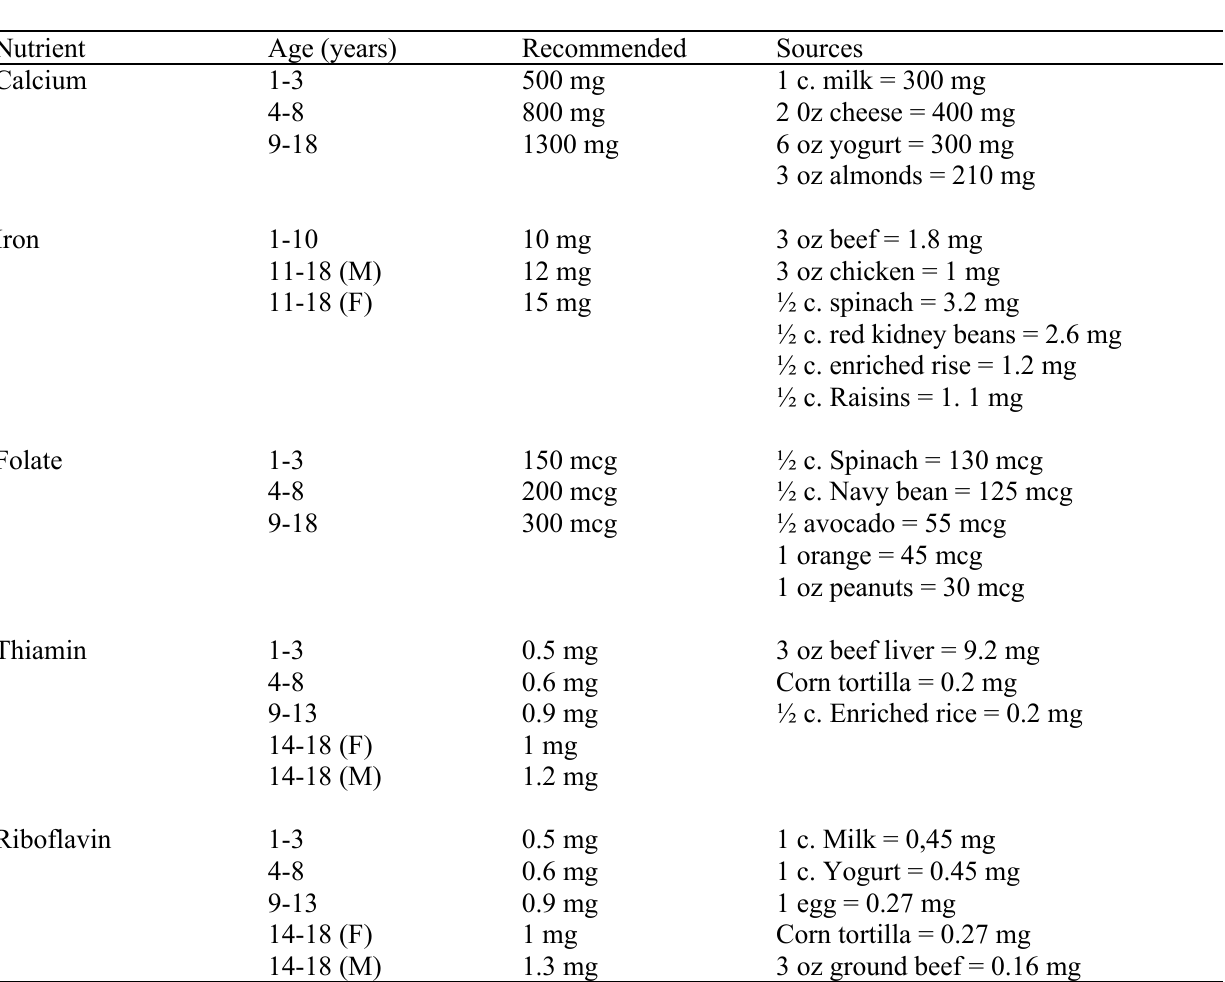
Table 2. Advantageous nutritional composition of pseudo-cereals Nutritional Characteristics of Amaranth, Buckwheat and Quinoa 31,32,33,34 High fiber content, 7–10 g/100 g, approximately the same as wheat fiber 9.5 g/100 g High content of essential amino acids: lysine, arginine, histidine, methionine and cysteine. High degree of unsaturated fatty acids, α-linolenic acid (35-50% of total fatty acid, oleic acid (25-35% of total fatty acid), and palmitic acid. High content of folic acid: quinoa and amaranth, 78.1 µg/100 g and 102 µg/100 g, respectively, vs. 40 µg/100 g in wheat.